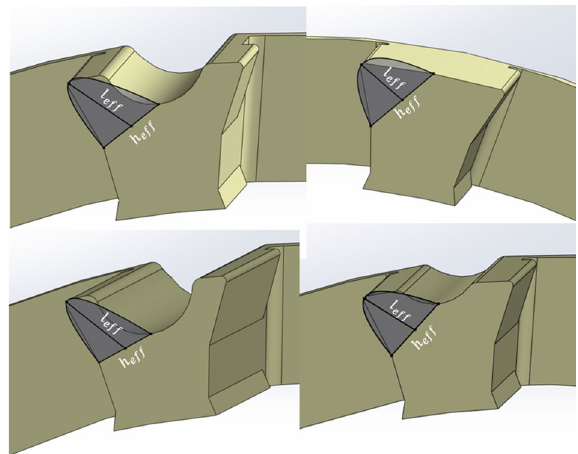
Figure 8. Modeling the deformed areas of the cages as a parabolic